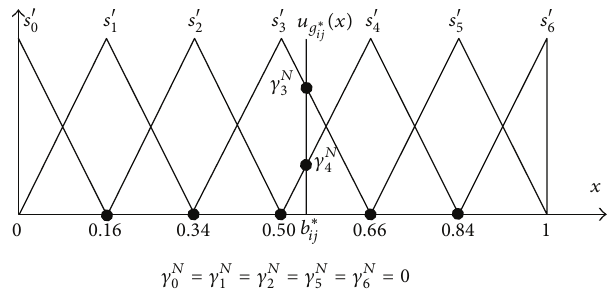
Figure 3: Illustration of transforming a real number to a linguistic term in the